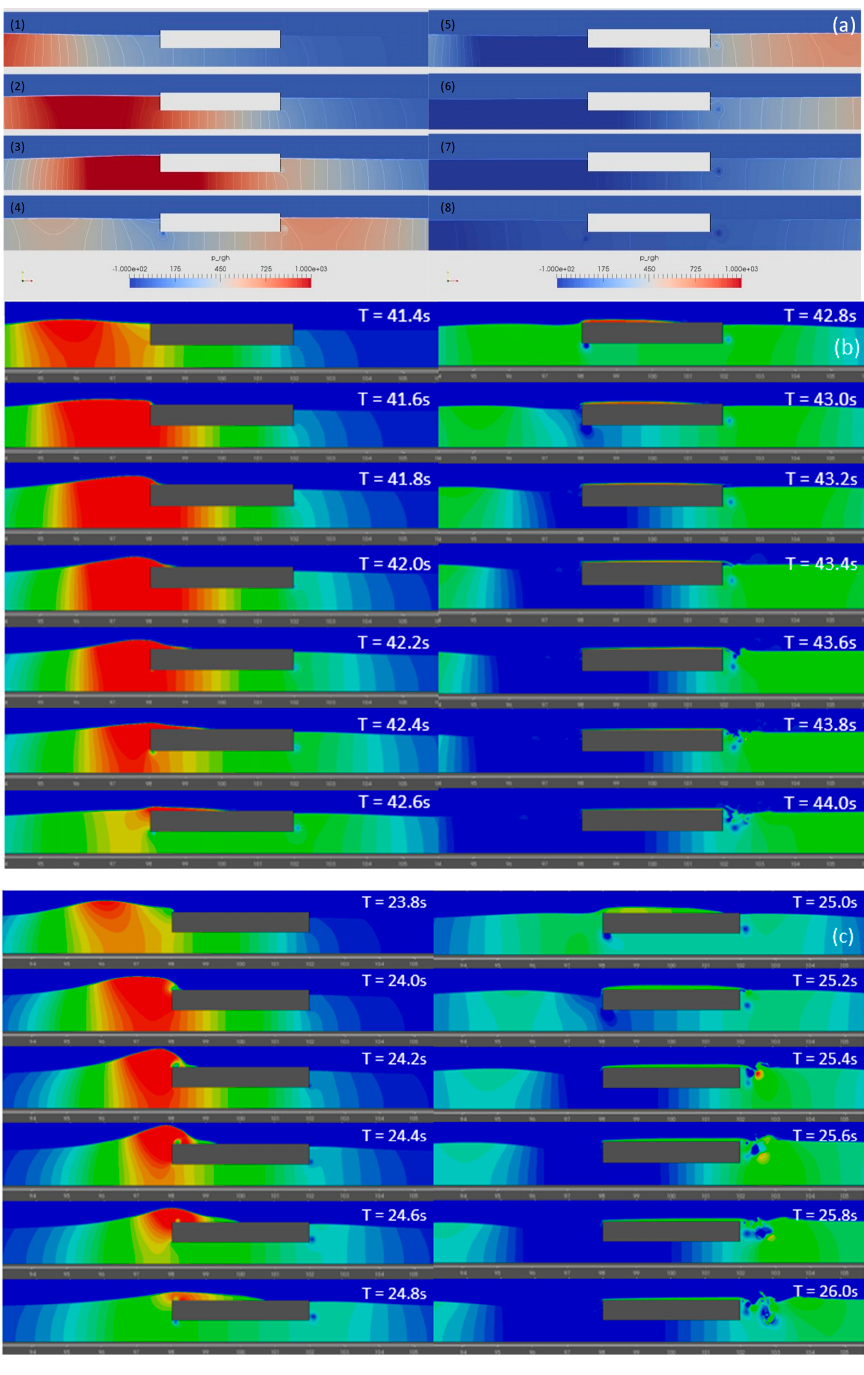
Figure 17. Pressure distribution ( a ) around the pontoon during the wave encounter (1–8 shows successive time steps) ( a ) OW3D, a / h = 0.1, in the fluid domain, while the solitary wave with the fixed pontoon ( b ) OW3D, a / h = 0.3, and ( c ) OW3D, a / h =